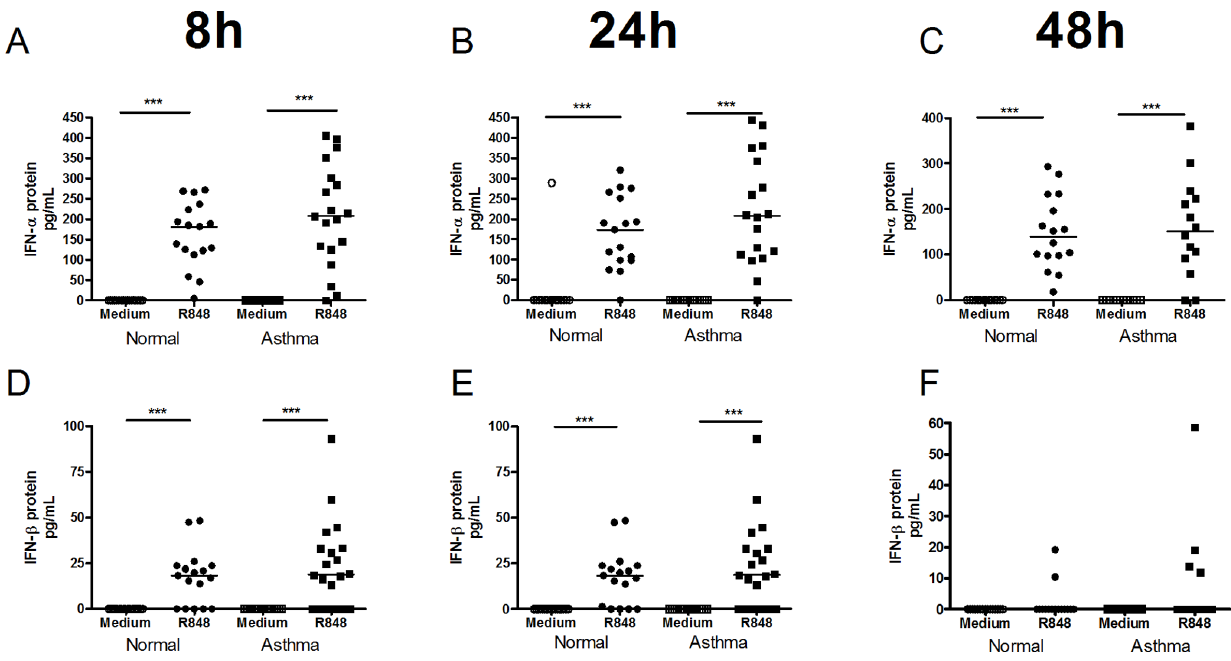
Figure 5. TLR7 stimulation induced type I but not type III IFN in PBMCs. Graphs depict IFN- a protein production 8 h [A], 24 h [B] and 48 h [C] and IFN- b protein at 8 h [D], 24 h [E] and 48 h [F] post R848 stimulation. Squares represent asthmatics, circles represent non-asthmatics. *=p , 0.05, **=p , 0.01, ***=p , 0.001.